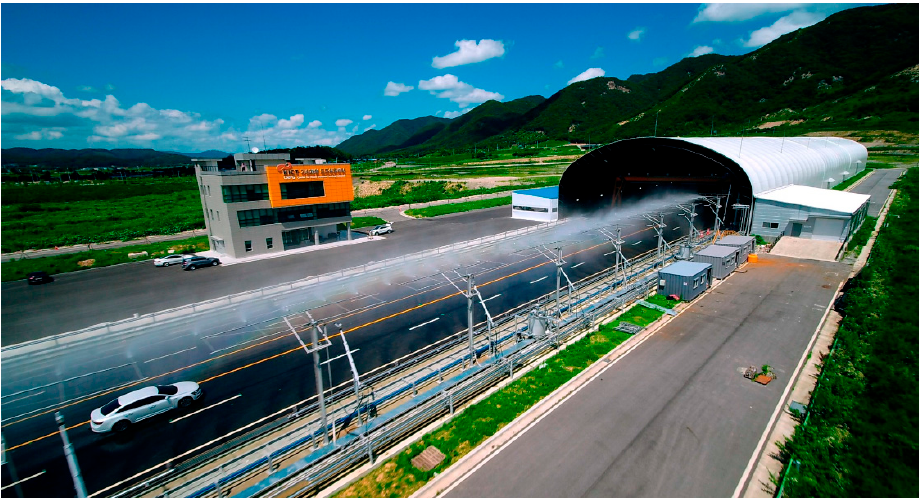
Figure 3. Test site (KICT SOC Demonstration Research Center).